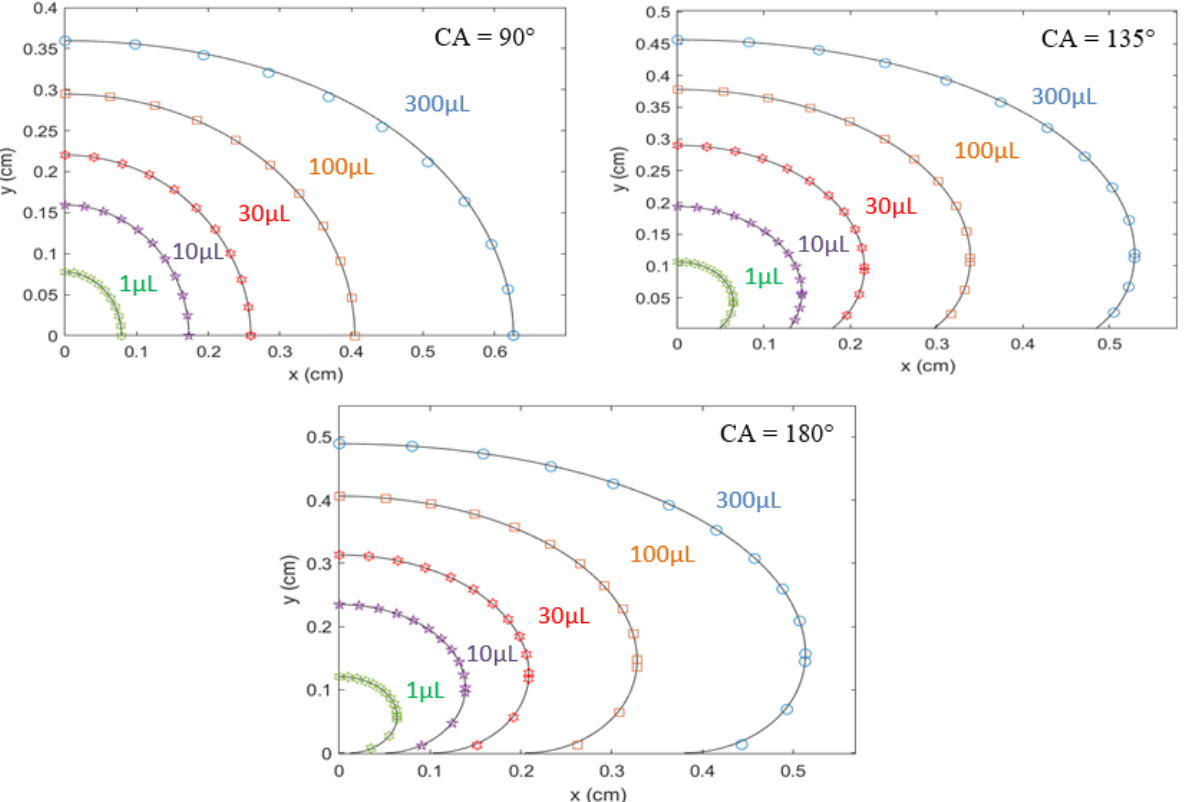
Figure 2. Comparison between droplet profiles with the Young–Laplace theoretical model (continuous lines) and elliptic